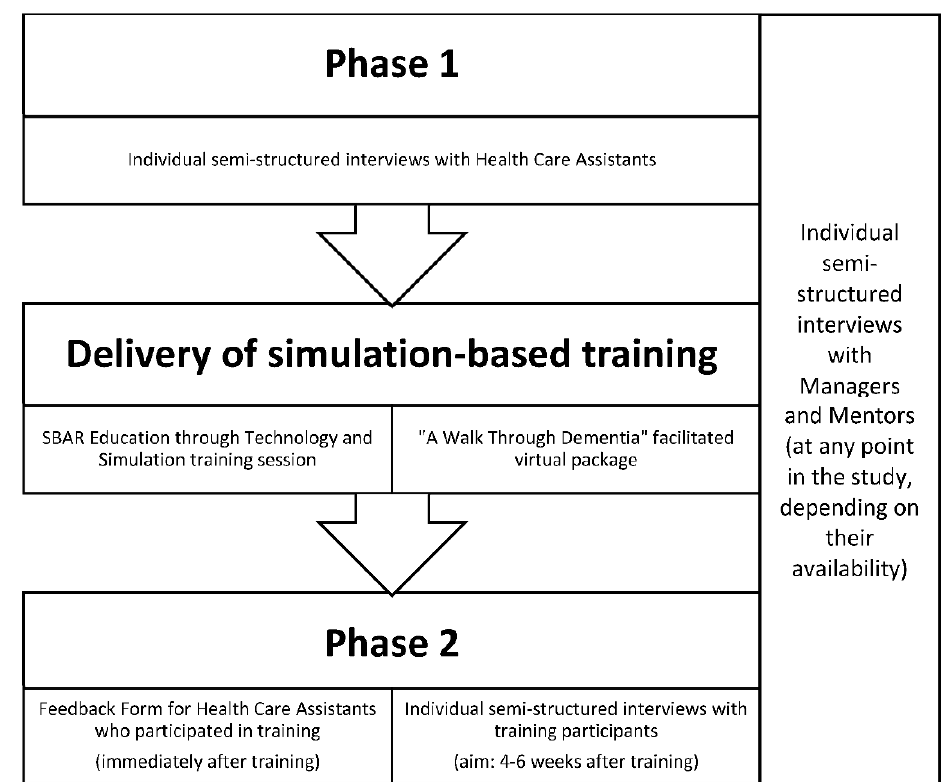
Figure 1. Flowchart showing study data collection in relation to training